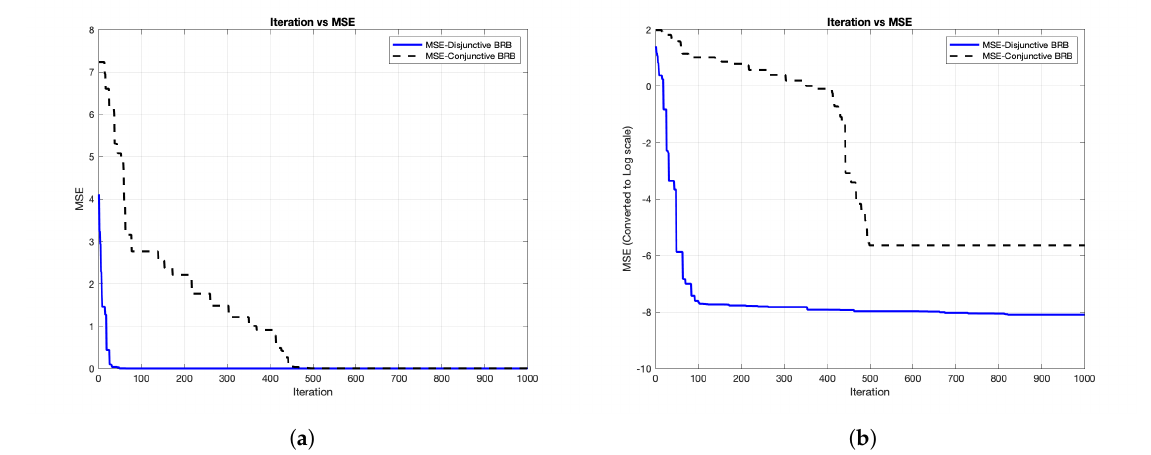
Figure 10. Convergence of PO and SO using BRBaDE for Conjunctive and Disjunctive BRB. ( a ) MSE; ( b ) MSE (Converted to Log